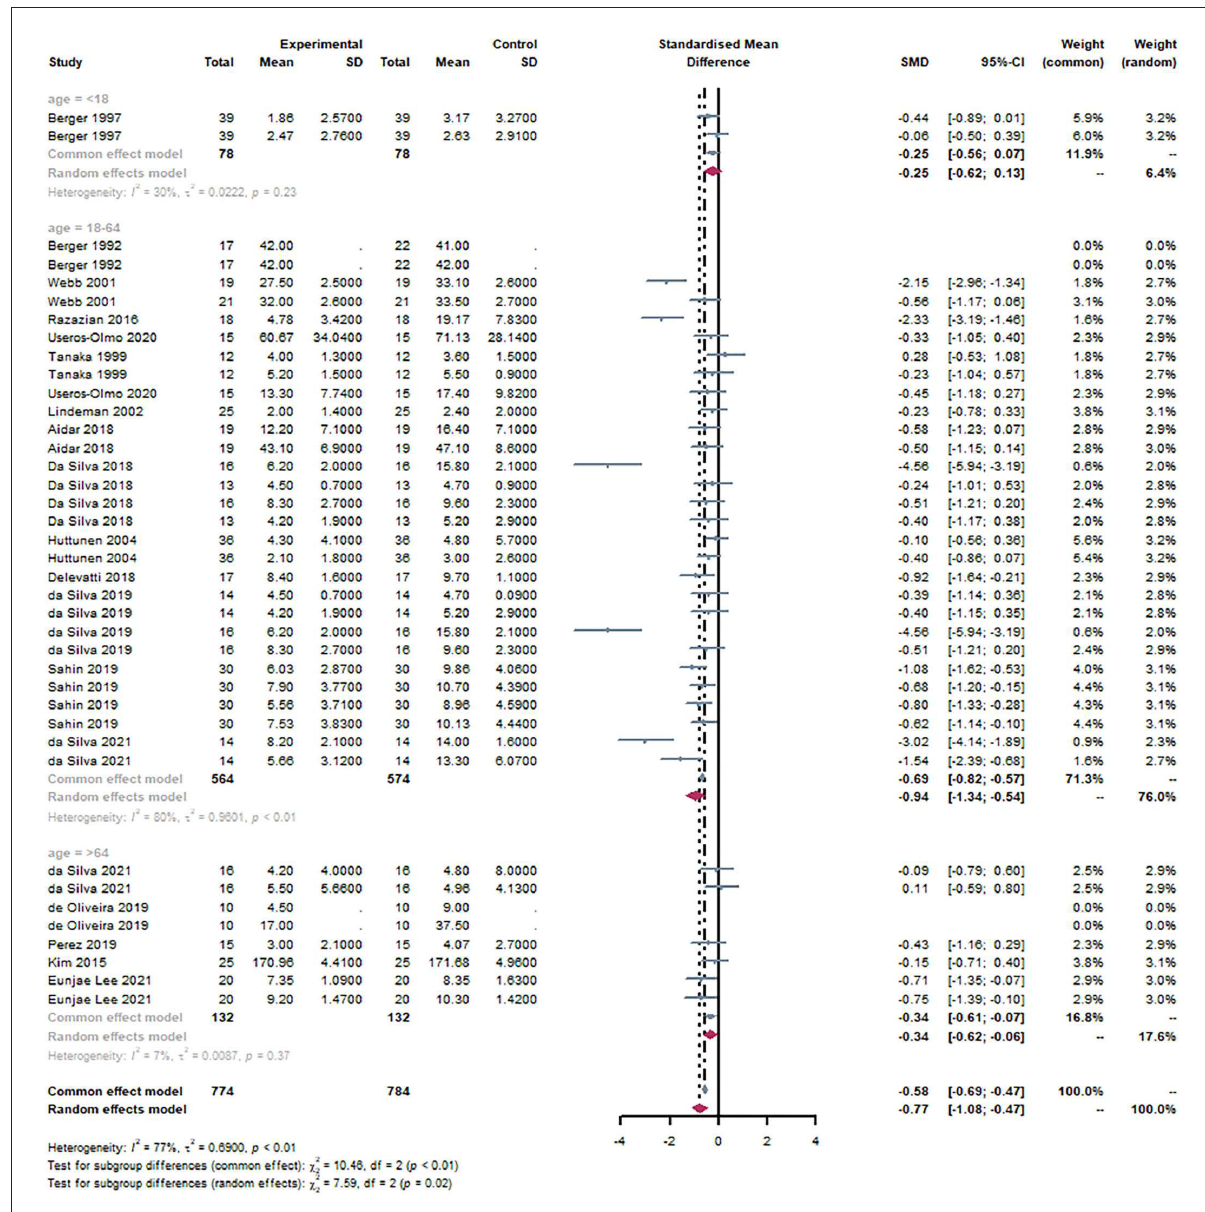
FIGURE5 Forest plot of age. By subgroup analysis of the age, 18–64 years [SMD = − 0.94, 95% CI ( − 1.34, − 0.54), I 2 = 80%, P < 0.01] were statistically significant.